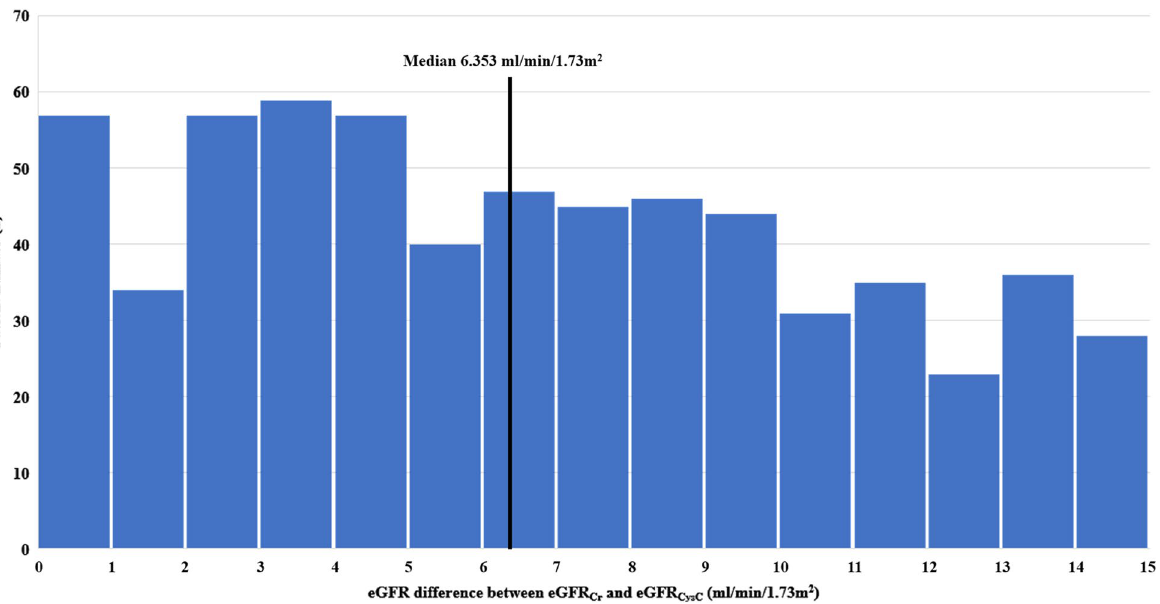
Figure 1. Distributions of differences between the eGFR Cr and eGFR CysC . eGFR, estimated glomerular filtration rate; eGFR Cr , eGFR based on creatinine; eGFR CysC , eGFR based on cystatin